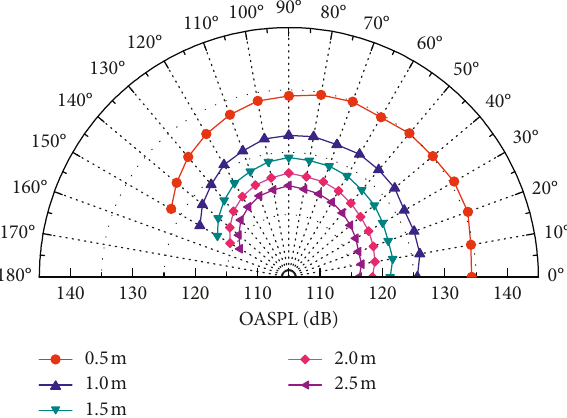
Figure 15: Noise directivity